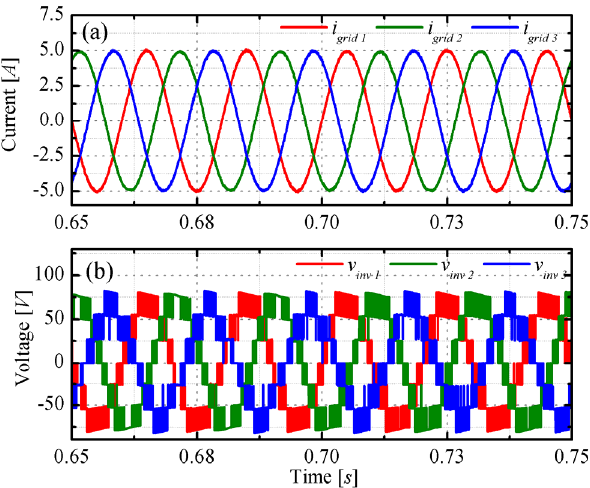
Figure 10. Partial shading: comparison among ( a ) phase currents i grid, p ; and ( b ) phase modulated voltages v inv,p .